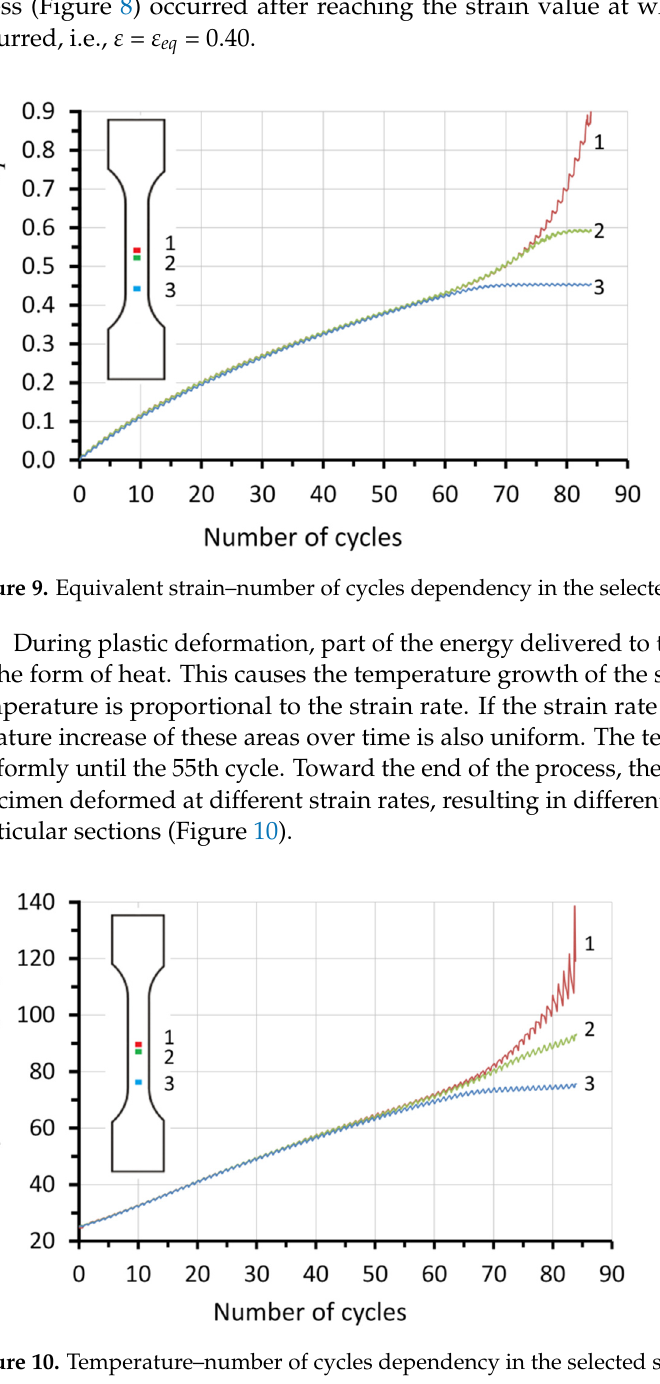
Figure 8. Kirchhoff and equivalent stress dependency, along with a thermal image of the tested specimen before fracture.